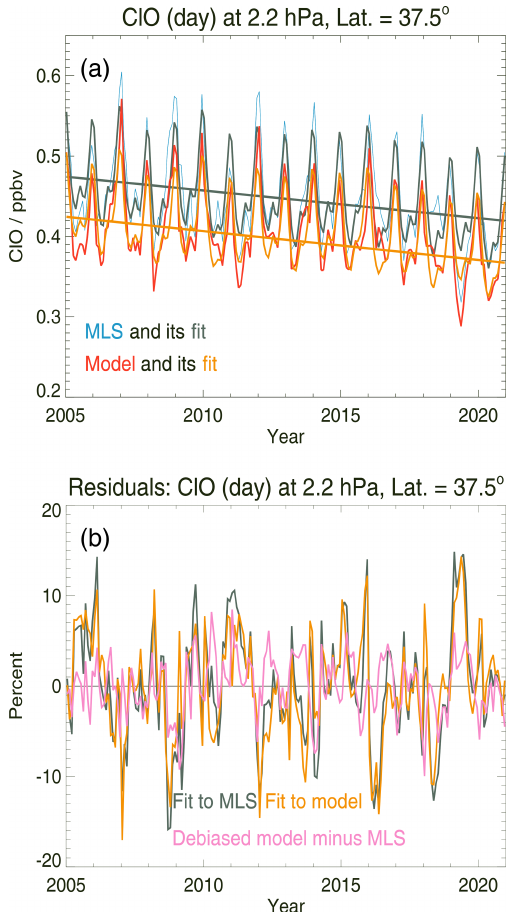
Figure 2. (a) Examples of MLS and model ClO (day) monthly zonal mean time series (2005 through 2020) for the 35–40 ◦ N lati- tude bin at 2.2hPa. The MLS data (blue) are fitted by a regression model (gray), and the model series (red) is fitted by the same type of regression model (orange). The dark gray and orange lines are the linear components of the corresponding fits to the MLS and model curves, respectively. (b) Percent residuals, for the fit to MLS (fit minus MLS) in gray, for the fit to the model (fit minus model) in orange, and for the debiased model minus MLS time series in